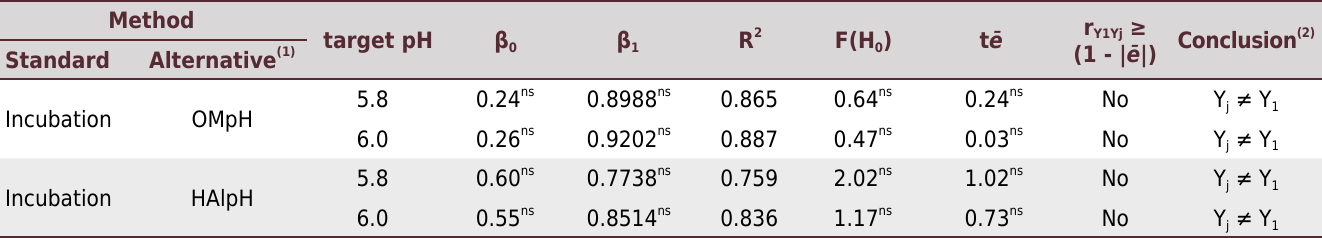
Considering 17 out of the 22 soil samples used to develop the new predictive models. (2) According to the statistical procedure proposed by Leite and Oliveira (2002). ns: not significant until 5